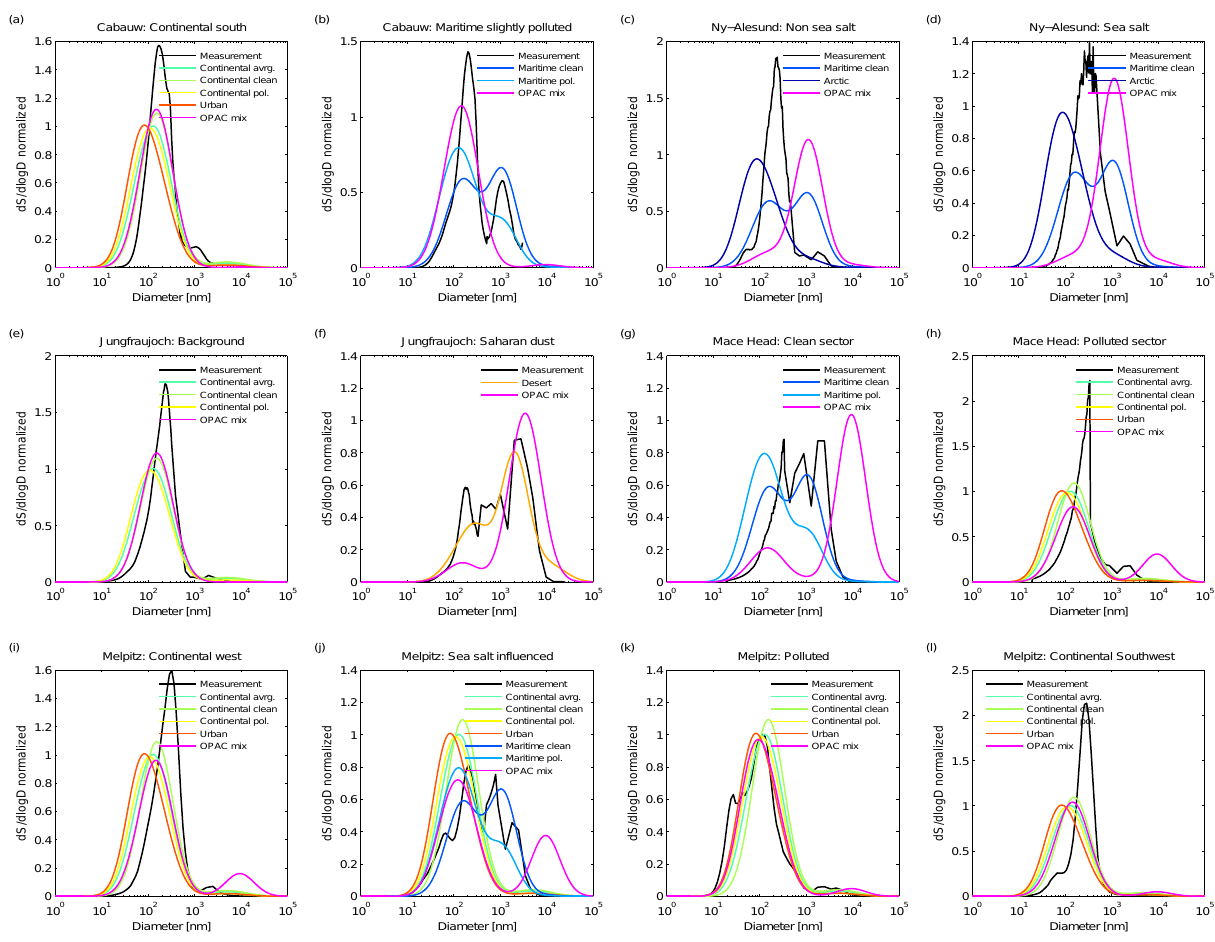
Fig. 10. (a–f) Normalized surface size distributions (black line) measured during the humidograph mode periods as shown in Figs. 8 and 9, normalized surface size distributions from the OPAC aerosol type examples (colored lines), and the OPAC size distributions if the individual components are weighted with the measured number size distribution (magenta line). Note that the OPAC components have a fixed mode diameter and therefore the OPAC individually mixed size distributions do not match the measured distribution in all